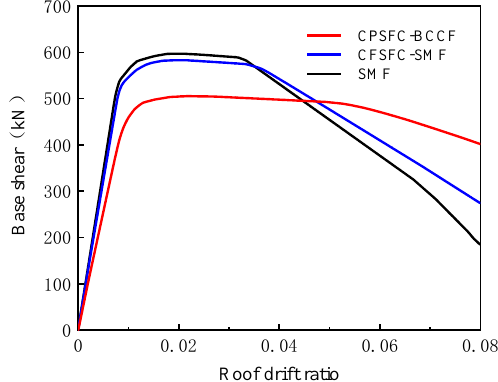
Figure 16. Bearing capacity curves.